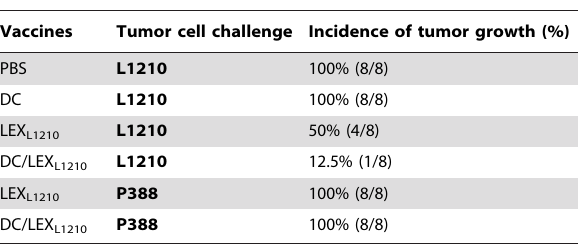
Table 1. Vaccination with LEXO and LEXO-targeted DC protects against tumor growth.